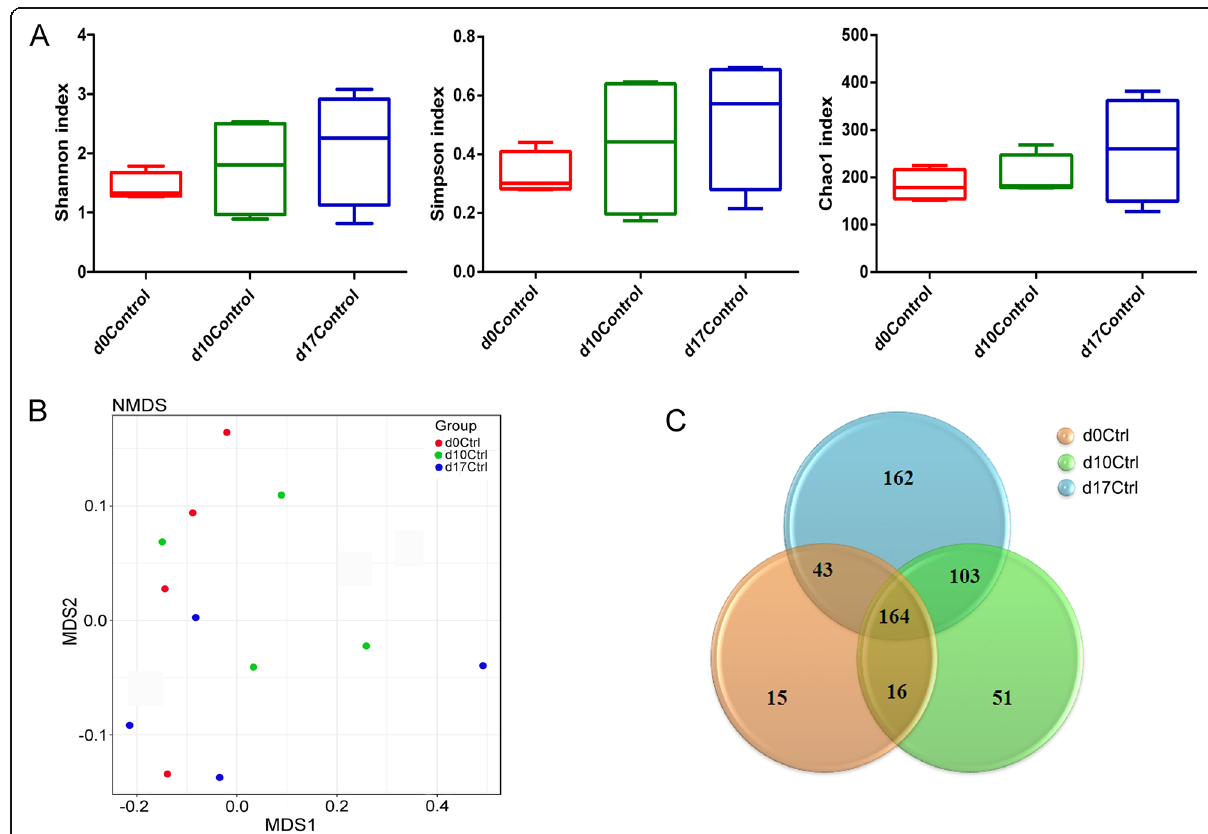
Fig. 2 Changes in the characteristics of gut microbiota in control (unexposed) rats in the course of a normal pregnancy. a Alpha-diversity of gut microbiome revealed by Shannon, Simpson, and Chao1 index. b The beta-diversity was revealed by non-metric multi-dimensional scaling (NMDS) analysis. c The unique and sharing operational taxonomic units (OTUs) numbers were presented in Venn diagram. D0 Ctrl means rats in control group before mating, d10 Ctrl and d17 Ctrl means the control rats in GD 10 and GD 17,